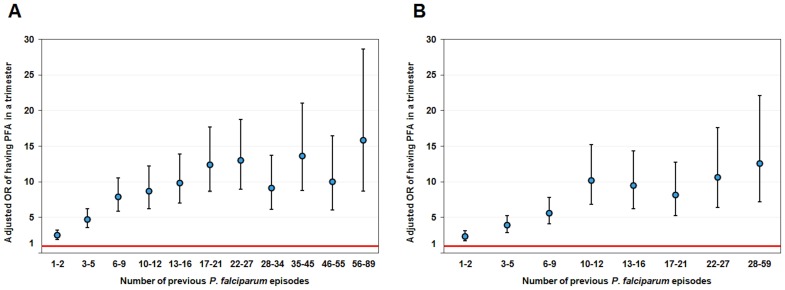
Odds ratio of having at least one P. falciparum clinical episode during the trimester.These odds ratios depend on the number of previous P. falciparum clinical episodes in either Dielmo village (A) or Ndiop village (B). Odds ratios were obtained by taking the exponential of the beta coefficients.